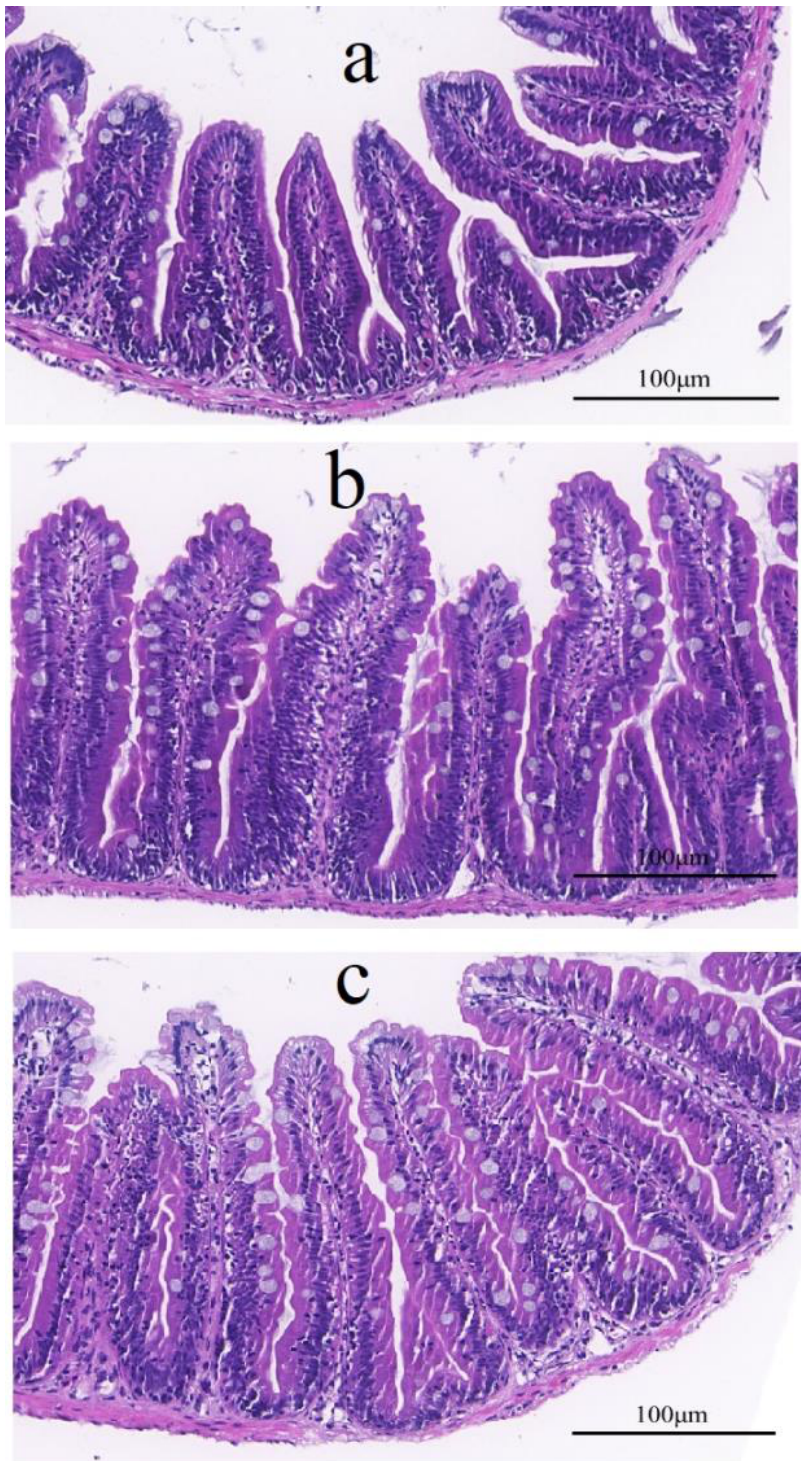
Figure 3. Representative HE-stained intestine sections from zebrafish fed with different diets ( p < 0.05). ( a ) Control; ( b ) 0.05% FWBP; ( c ) 0.1% FWBP. FWBP: Fermented wheat bran polysaccharides. Scale bars = 100 µm.